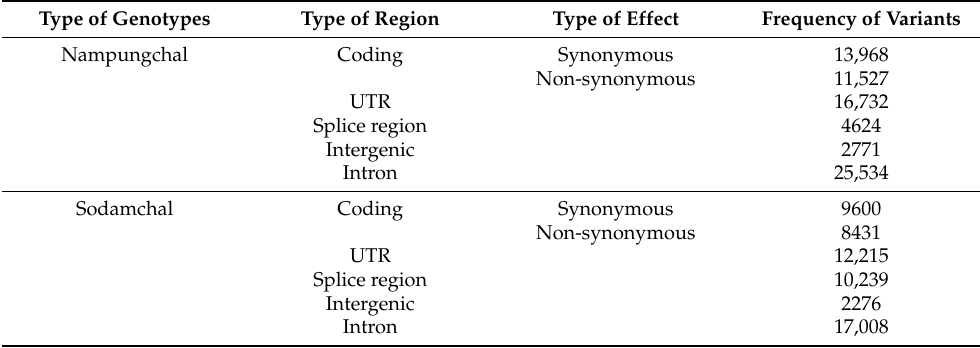
Table 1. Distribution of variants in two sorghum cultivars based on gene functional